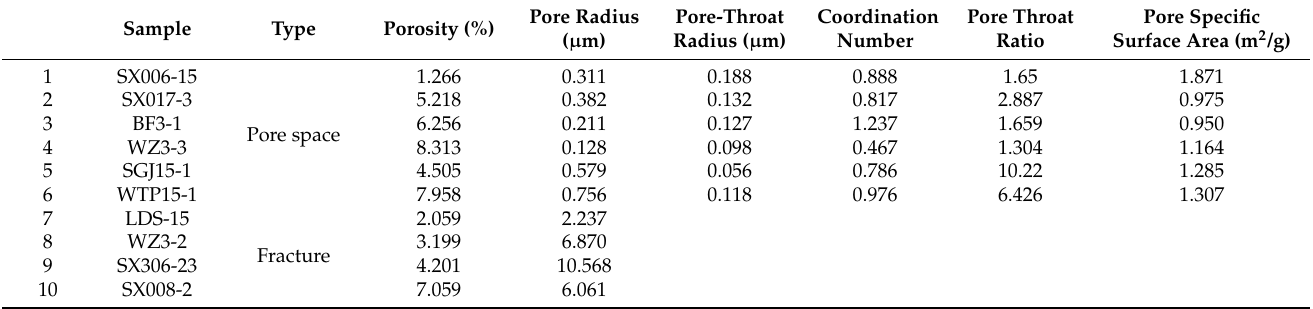
Table 2. Pore structure parameters calculated by image–algorithm quantitative analysis.